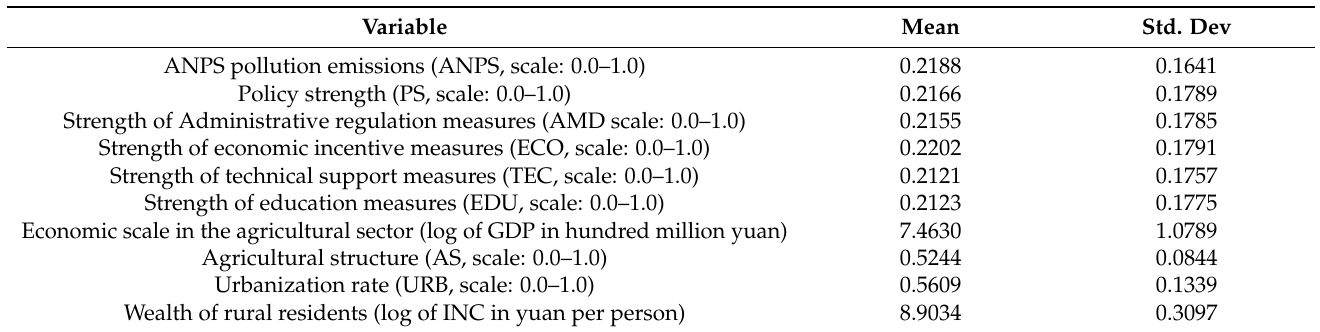
Table 4. Description of major variables.